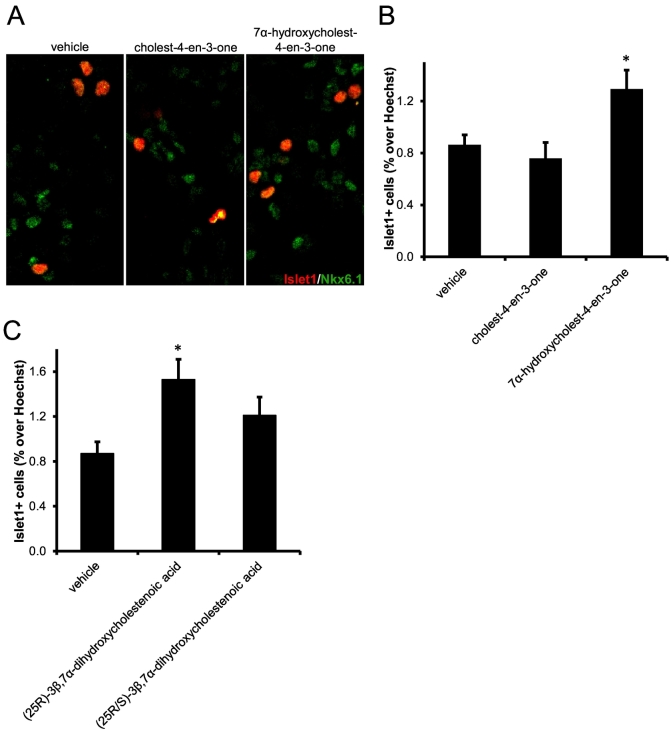
The PXR ligand 7α-hydroxycholest-4-en-3-one increases the number of Islet-1+ oculomotor neurons in mouse E11.5 midbrain primary cultures, but 3β,7α-dihydroxycholest-5-en-(25S)26-oic acid does not. (A) Representative Islet-1+ and Nkx6.1+ stained cell nuclei in cultures treated with vehicle, cholest-4-en-3-one or 7α-hydroxycholest-4-en-3-one. Quantitation of Islet-1+ neurons in primary cultures from E11.5 embryos treated with (B) vehicle, cholest-4-en-3-one or 7α-hydroxycholest-4-en-3-one, and (C) vehicle, 3β,7α-dihydroxycholest-5-en-(25R)26-oic or 3β,7α-dihydroxycholest-5-en-(25R/S)26-oic acid. * P < 0.05 vs vehicle treatment, Mann-Whitney test.